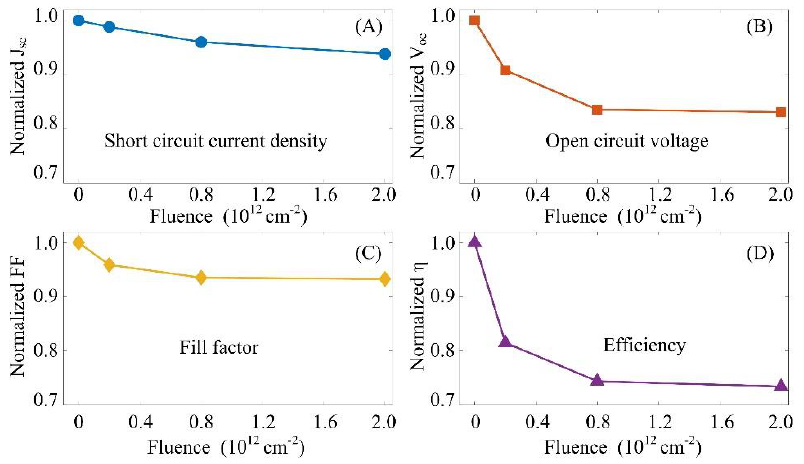
Figure 4. Degradation of ( A ) J sc , ( B ) V oc , ( C ) FF, and ( D ) η of the IMM3J solar cell as a function of fluence for 2 MeV proton irradiation.